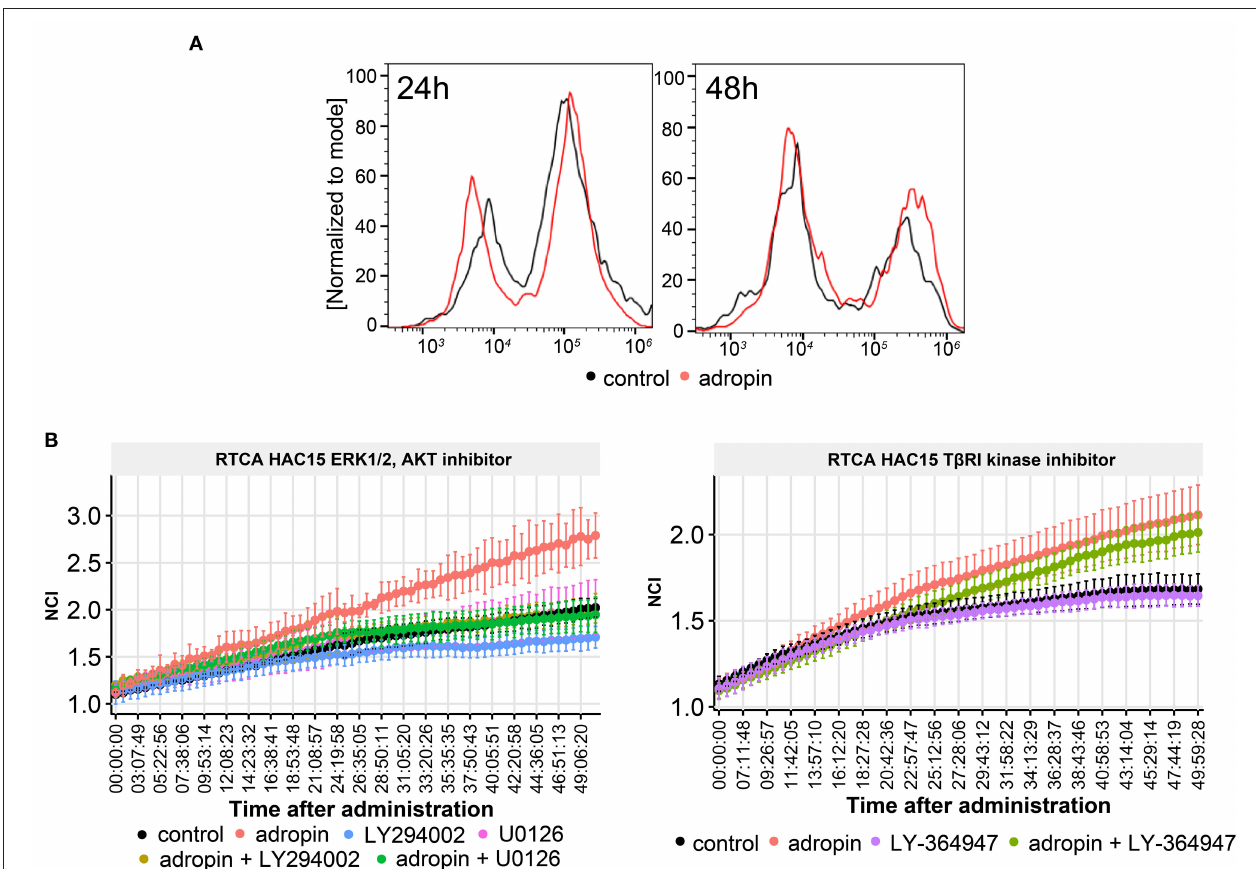
FIGURE 11 | The role of adropin in HAC15 cell proliferation. (A) Flow cytometry study on the contribution of adropin (10 − 8 M concentration) in stimulation of HAC15 cell proliferation, measured at 24 and 48h after peptide administration. (B) Effect of ERK 1/2, AKT and TBRI kinase inhibitors on adropin-induced HAC15 cell proliferation using xCelligence Real-Time Cell Analyzer–RTCA (B) . The RTCA chart presents mean normalized cell index (NCI) +